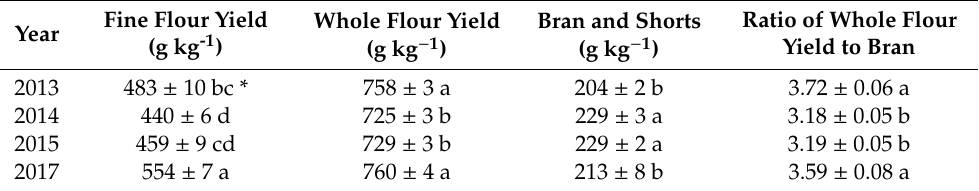
Table 6. Mean values ( ± SE) of winter wheat flour yield over farming system treatments and experimental